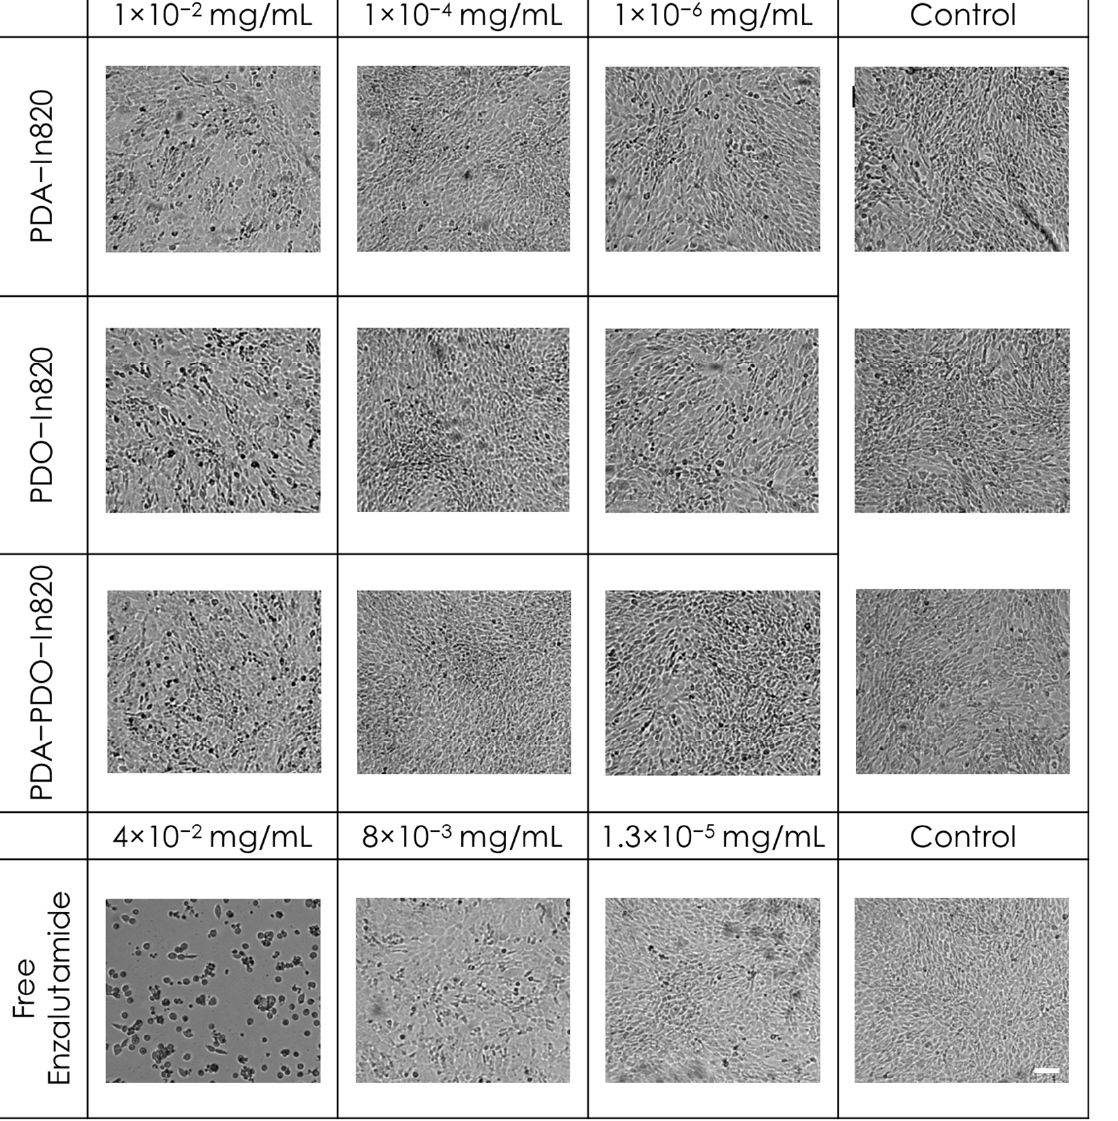
Figure 9. Images of 3T3 cell morphologies incubated with nanoparticles at various concentrations of the different copolymers and free enzalutamide. Scale bar = 100 μ m.